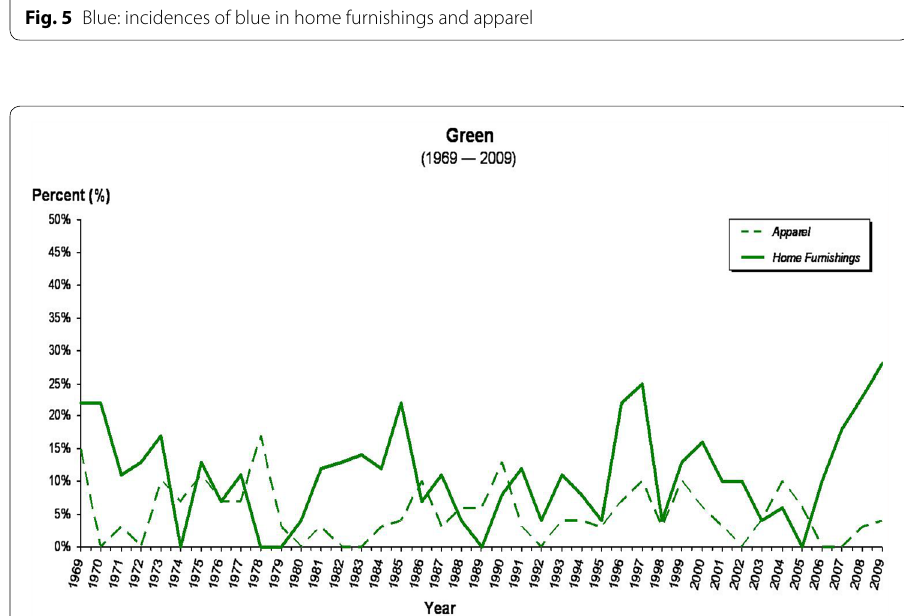
Purple: HF (1 + –6 + years), AP (3–12 years). Blue: HF (4–10 years), AP (3 + –21 + years). Green: HF (2–10 years), AP (1 + –10 years). Brown: HF (5 + –25 + years), AP (2–10 + years). Gray: HF (1 + –5 years), AP (2–4 years). Black: HF (1 + –6) years), AP (3 + –19 + years). White: HF (2 + –27 years), AP (5 + –24 + years). No clear, overall pattern of change in color cycle lengths was found for the period. HF cycles lengthened in yellow, purple, and brown; no HF colors appeared to trend towards